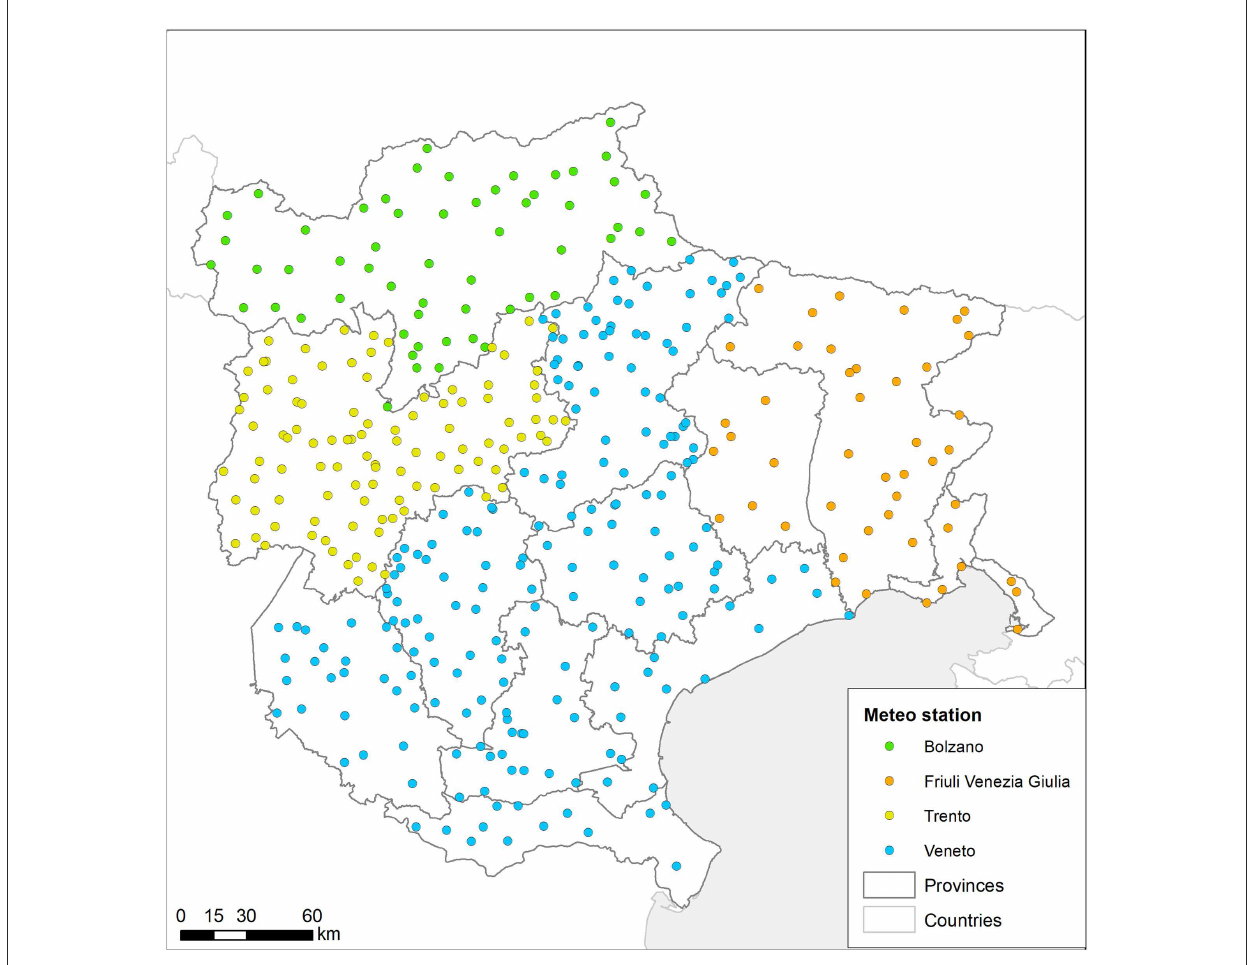
FIGURE6 Ground sensed data derived from meteo stations located in different regions and autonomous